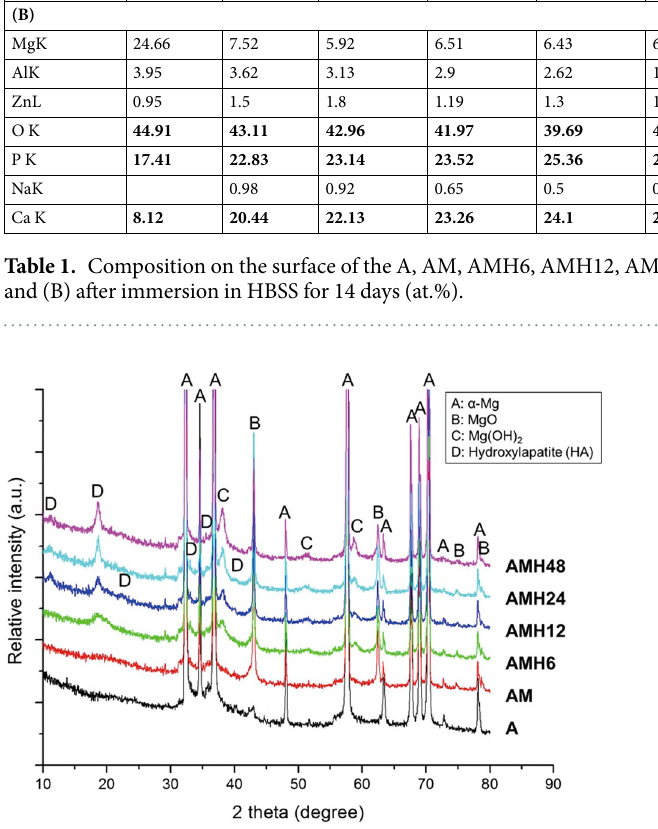
Figure 2. XRD patterns of the A-, AM-, AMH6-, AMH12-, AMH24- and AMH48-treated